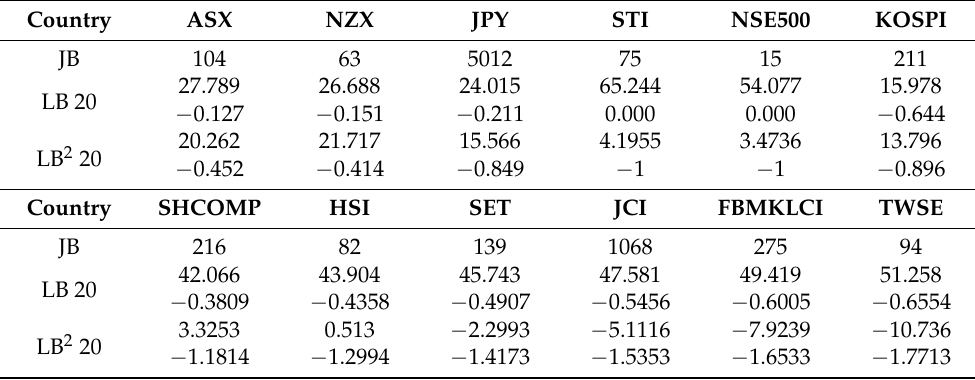
Table A5. Diagnostics for the EGARCH Residuals—Stock